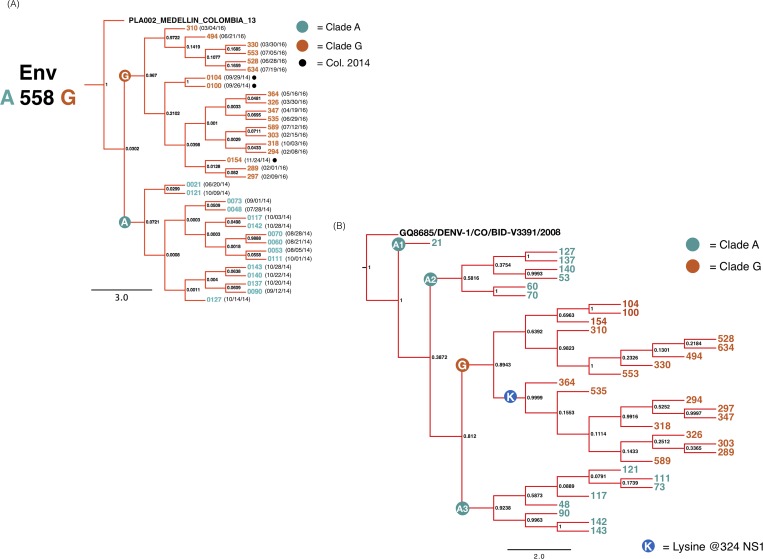
Phylogenetic relation of DENV-1 sequences collected at the Paris neighborhood fever clinic.(A) A closer look at the clade containing all DENV-1 sequenced from our study site (marked by star) in Fig 2. Bayesian Maximum Clade Credibility tree of 34 DENV-1 E gene nucleotide sequences from viruses collected at our study site reconstructed using a Markov Chain Monte Carlo (MCMC) approach as implemented by the program BEAST v1.8, under a HKY + Γ + Ι model and otherwise default parameters. Dates formatted in (mm/dd/yy). (B) Whole genome based phylogenetic relation. Bayesian Maximum Clade Credibility tree of 34 DENV-1 complete protein coding sequences from viruses collected at our study site reconstructed using a Markov Chain Monte Carlo (MCMC) approach as implemented by the program BEAST v1.8, under a HKY + Γ + Ι model and otherwise default parameters.